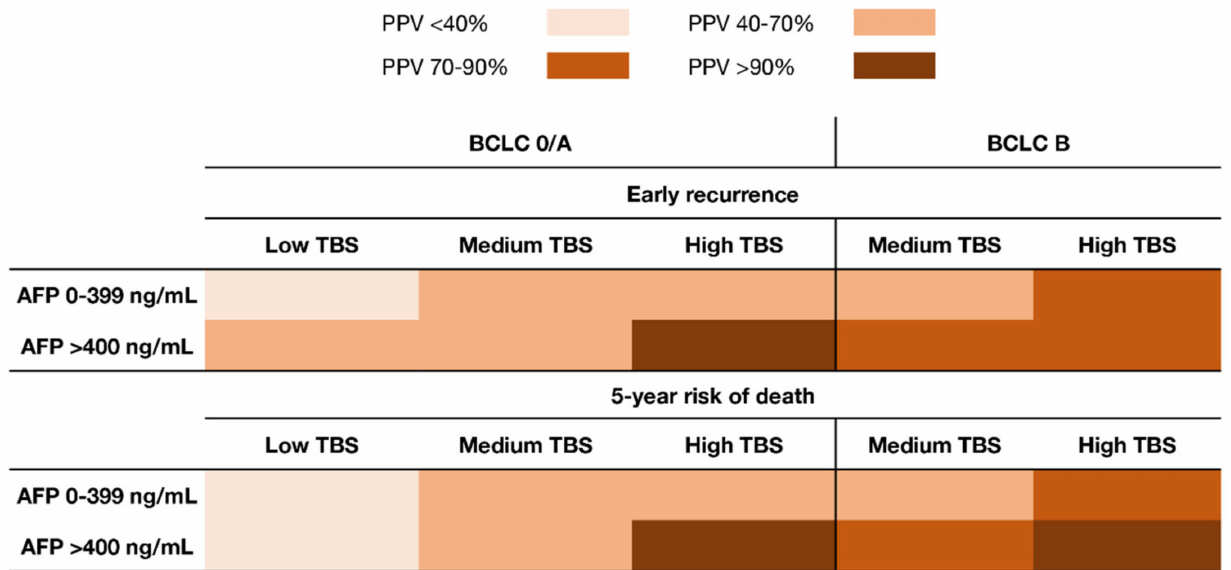
Figure 3. Heat map demonstrating differences in the PPV of TBS and AFP levels relative to early recurrence and 5-year mortality after resection for HCC stratified by BCLC-0/A and BCLC-B